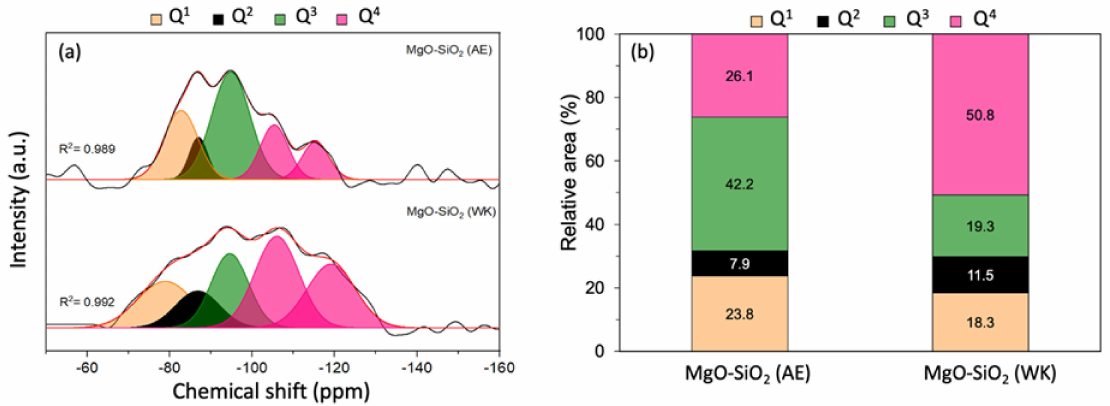
Figure 3. ( a ) 29 Si MAS NMR spectra of MgO-SiO 2 prepared by ammonia evaporation (AE) and wet-kneading (WK) and ( b ) relative areas of the Q n